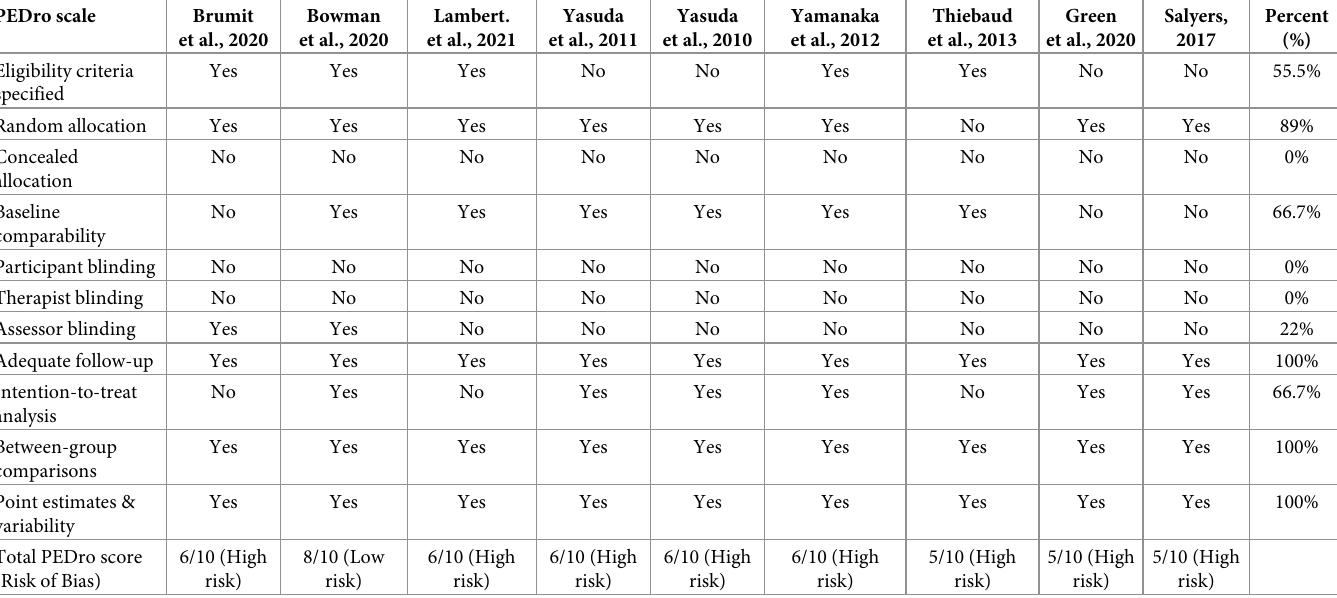
Table 3. Methodological quality and risk of bias of the included studies (PEDro